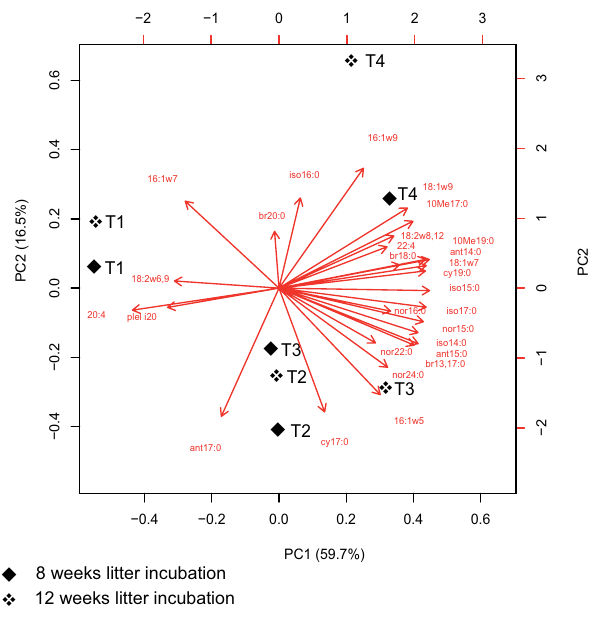
Fig. 5. First PC1 and second PC2 principal components of the prin- cipal component analysis (PCA) illustrating the relative ordination of the various locations after 8 and 12 weeks based on their 13 C- litter enriched soil PL profiles (in % relative to total 13 C derived from litter into total PL according to Fig. 1; means of n =